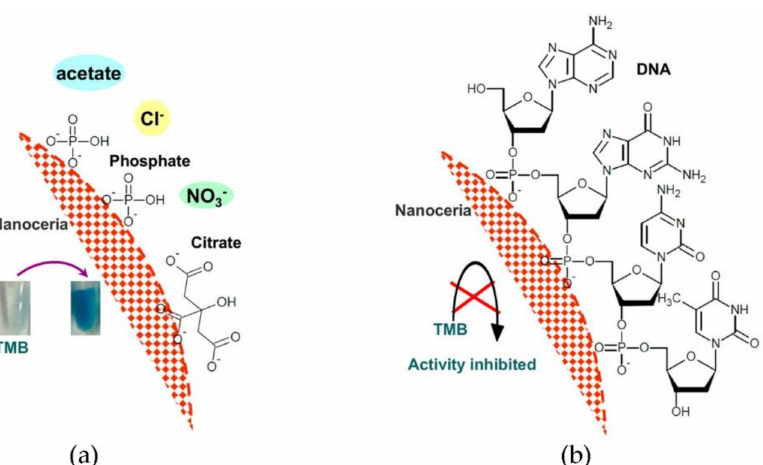
Figure 5. ( a ) Ceria binds with phosphate and citrate with higher affinity than acetate, chloride, or nitrate. In all these buffers, its oxidase-like activity is not affected, as it is able to convert 3,3 (cid:48) ,5,5 (cid:48) -tetramethylbenzidine (TMB) into a blue product. ( b ) Ceria binds DNA through the phos- phate groups independently from the DNA sequence and DNA adsorption impairs its oxidase-like activity. Reprinted with permission from [62], Copyright © 2021, American Chemical